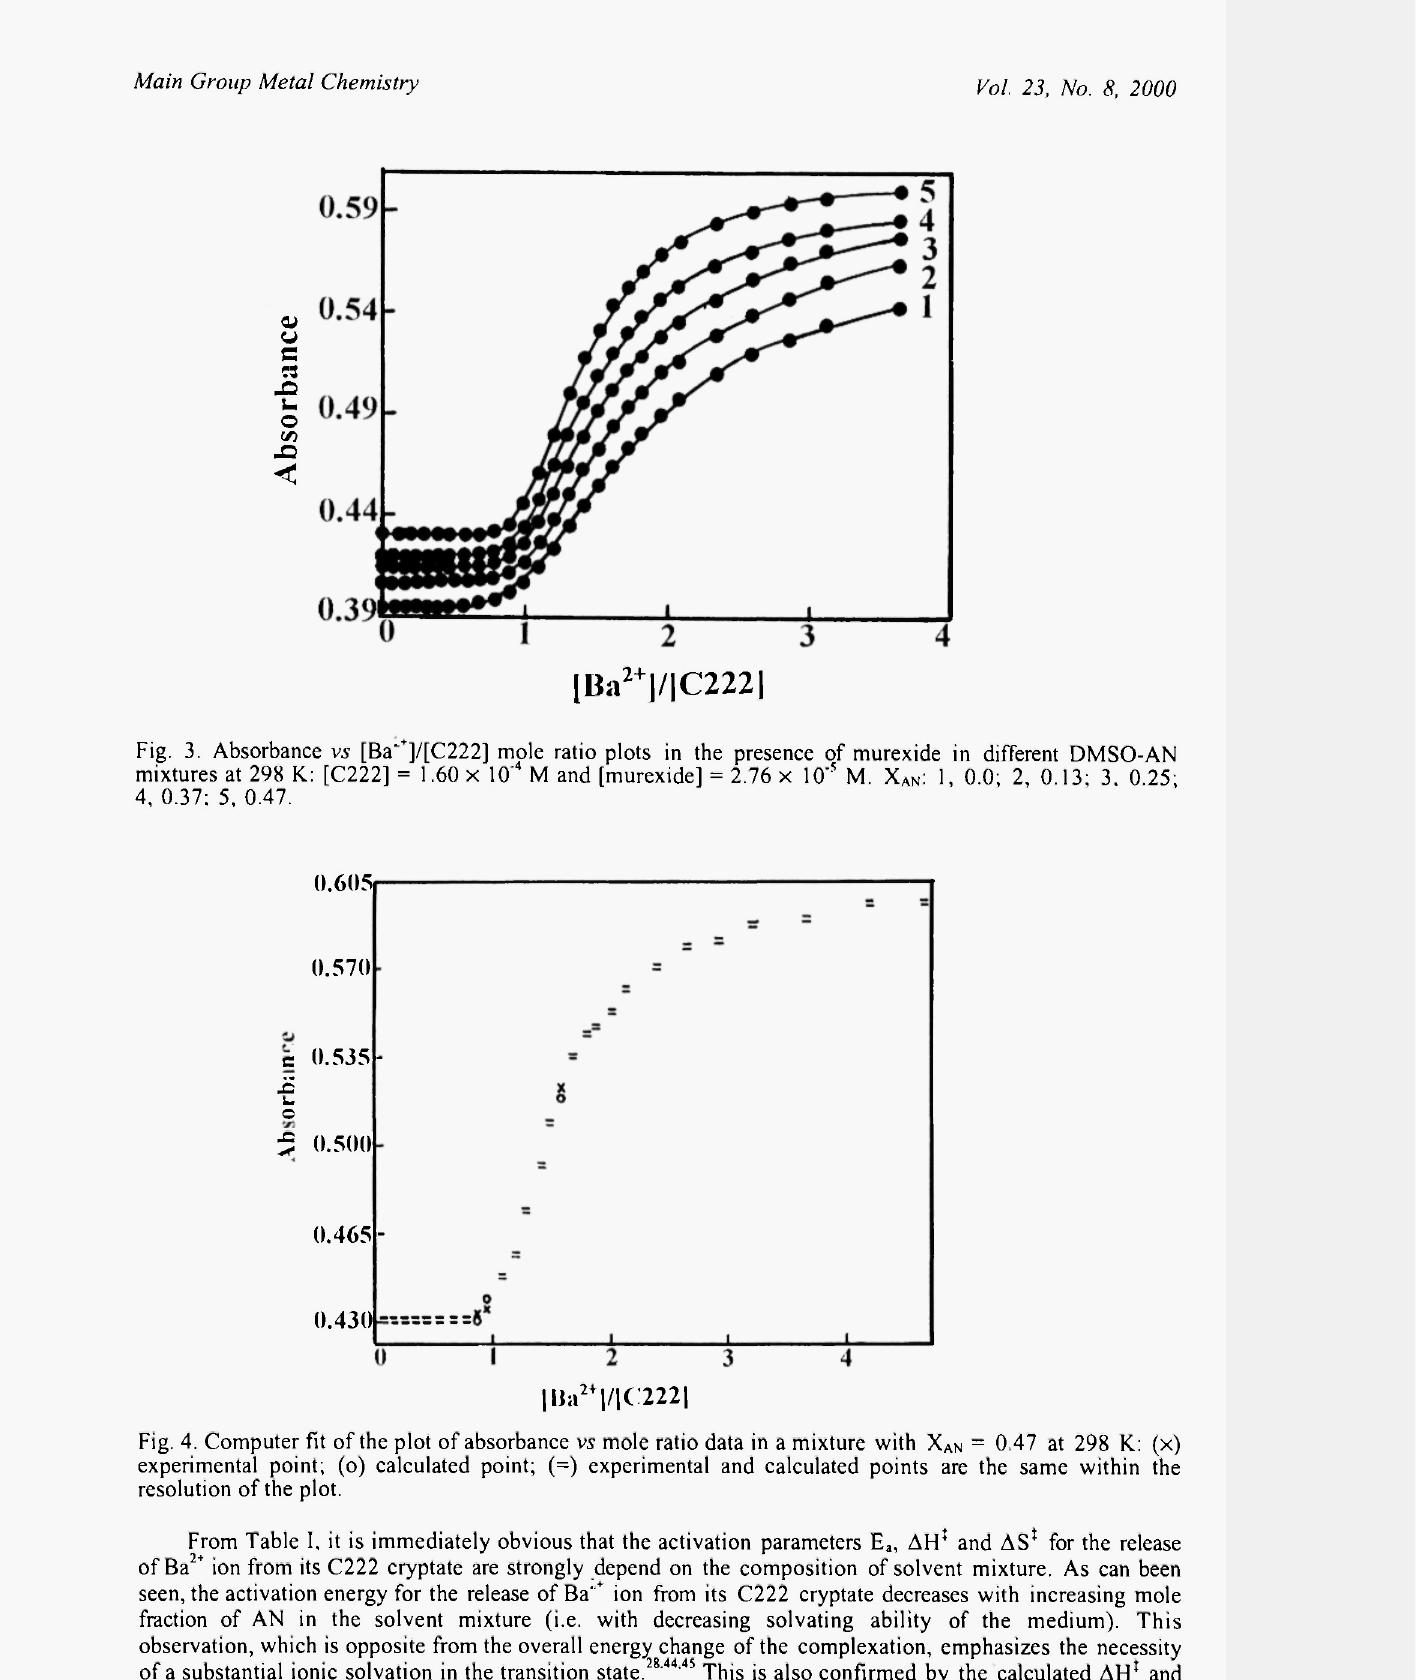
Fig. 4. Computer fit of the plot of absorbance vs mole ratio data in a mixture with X A N = 0.47 at 298 K.: (x) experimental point; (o) calculated point; (=) experimental and calculated points are the same within the resolution of the